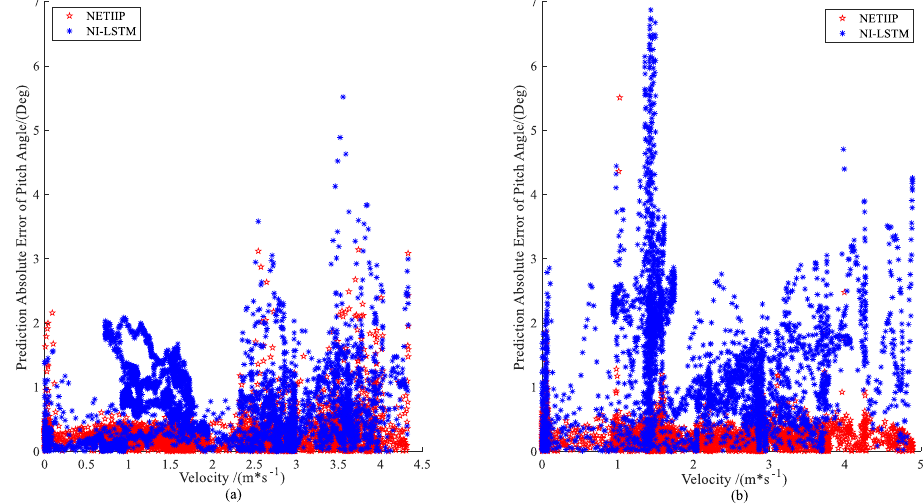
Figure 15. Prediction error – velocity distribution of ship attitude: ( a ) MRM and ( b ) ANM.